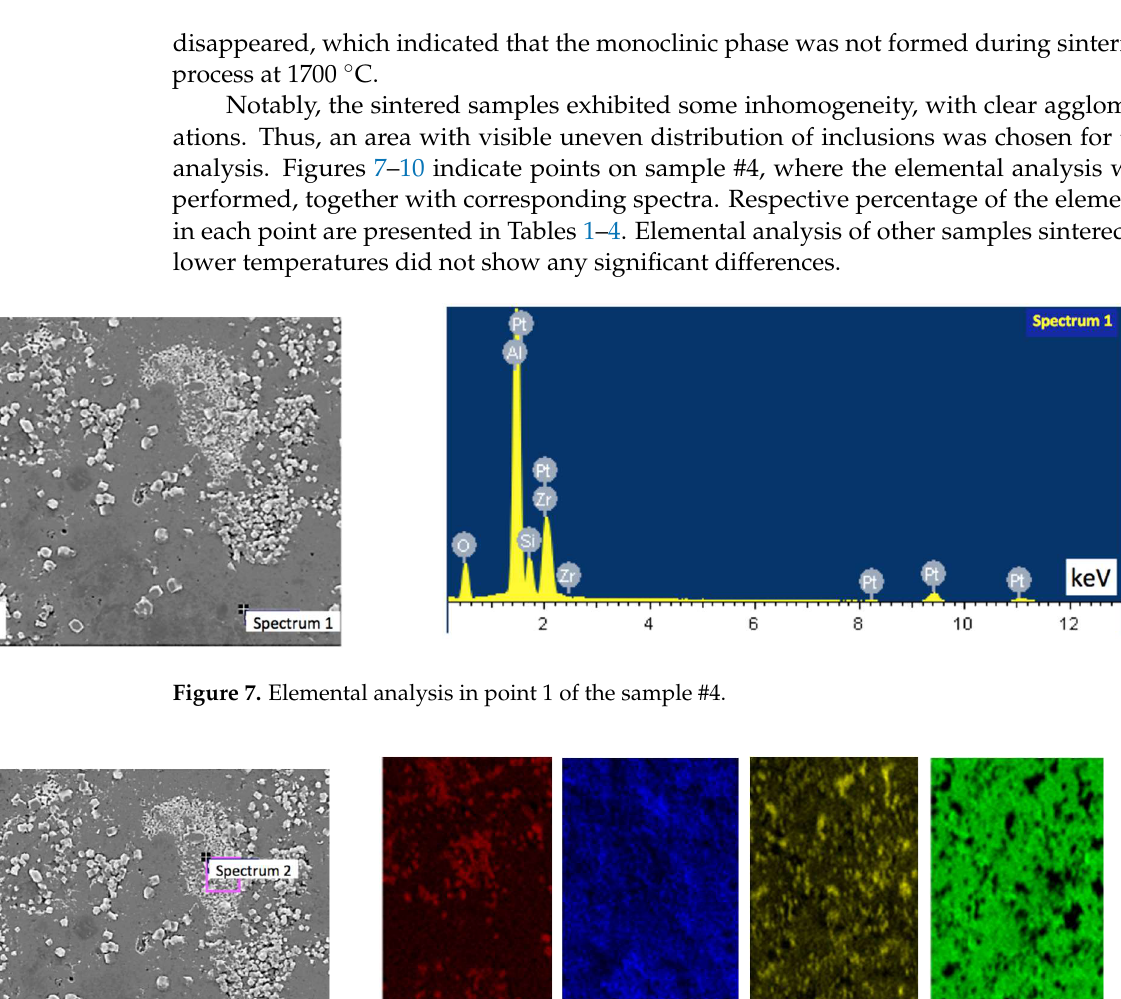
Figure 8. Elemental analysis in point 2 of the sample #4. Table 2. Elemental proportions in point 2 of the sample #4.